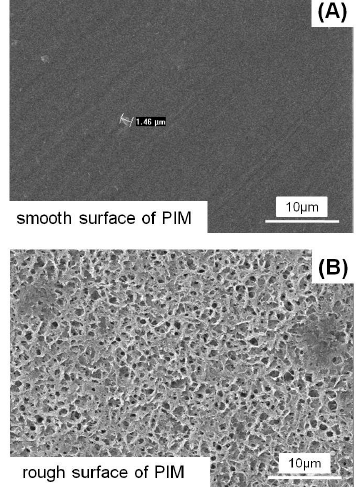
Figure 1. Representative SEM images of 5 wt % nHA loaded PLGA phase inversion membrane (PLGA PIM + 5 nHA), which presented an asymmetric structure: ( A ) Smooth surface; and ( B ) Rough surface with the average pore diameter being about 2–3 μ m. SEM, scanning electron microscope. PIM, phase inversion membrane.